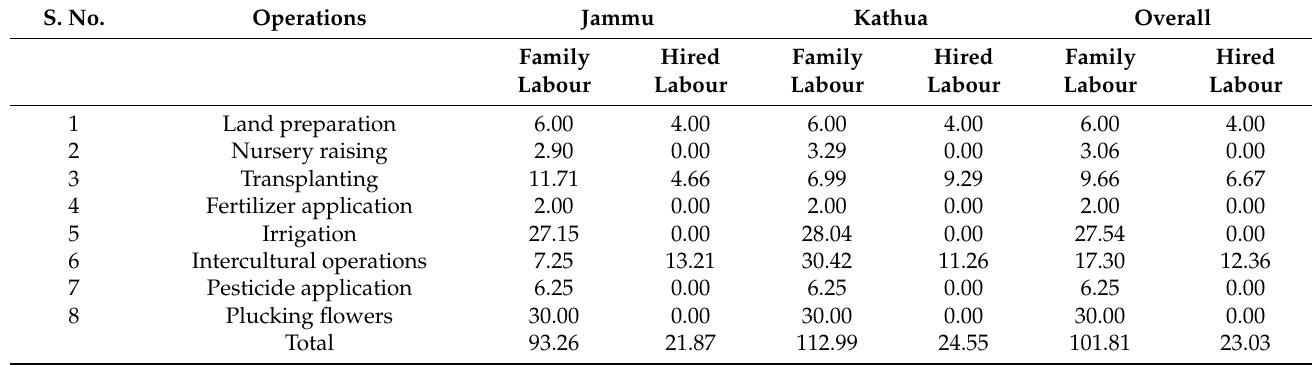
Table 4. Operation-wise employment (mandays) generated in marigold cultivation.